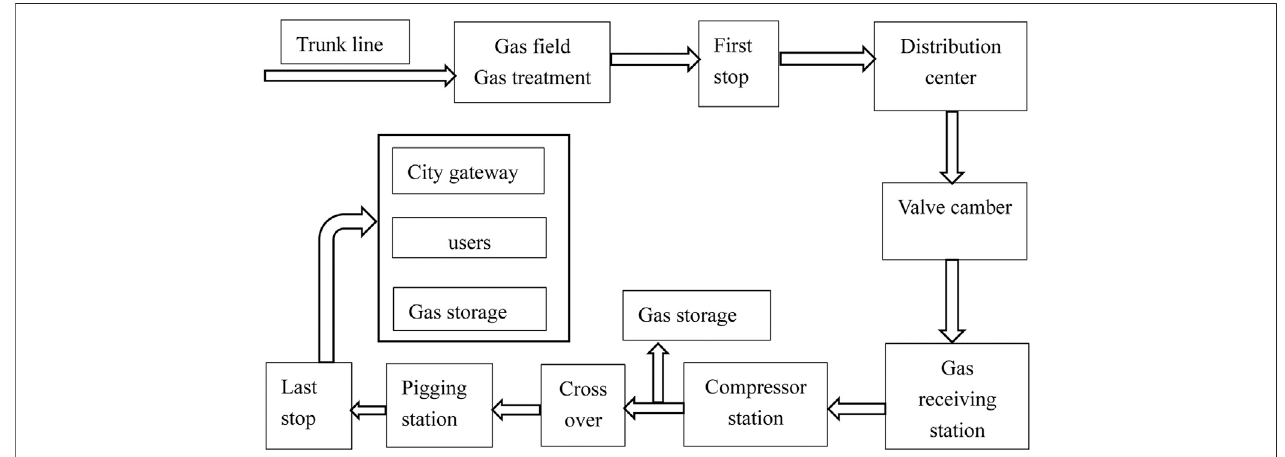
FIGURE 4 | The overall process of the natural gas gathering and transportation pipeline system (Li,